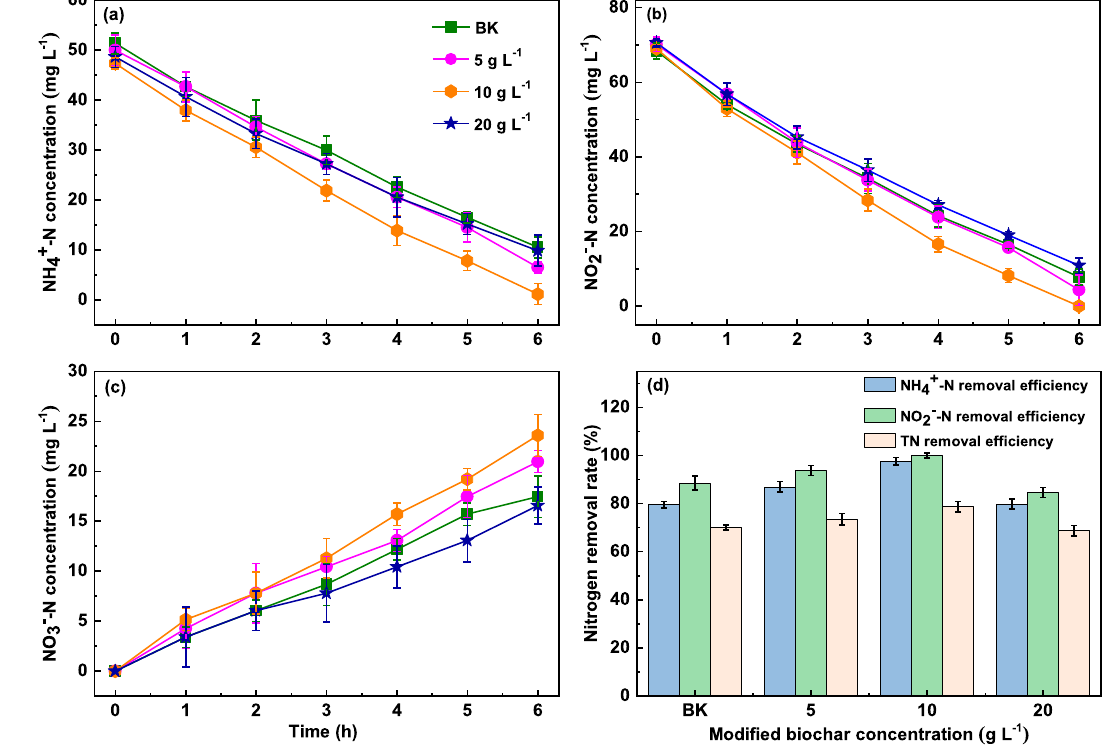
Fig. 2 Nitrogen removal performance of the four reactors under variational modified biochar concentrations. a variations of NH 4 + -N concentrations; b variations of NO 2 − -N concentrations; c variations of NO 3 − -N concentrations; d nitrogen removal efficiency